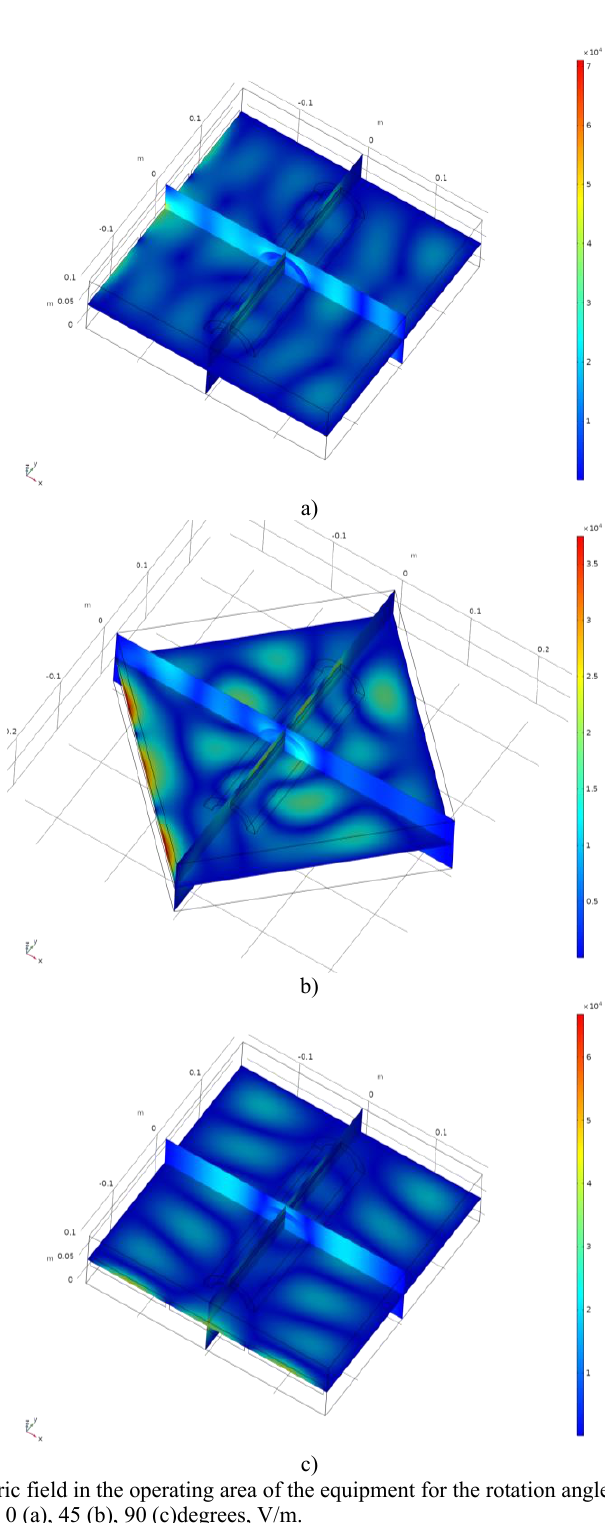
Fig. 2. The electric field in the operating area of the equipment for the rotation angles of the workpiece 0 (a), 45 (b), 90 (c)degrees,